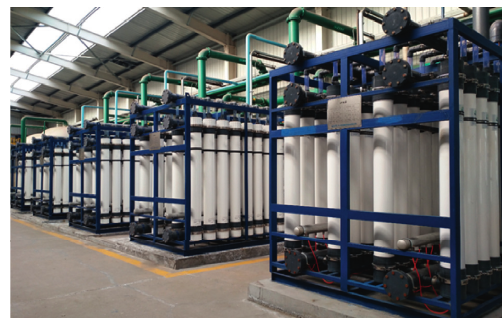
Figure 8: Mid-ring membrane thermal ultrafiltration